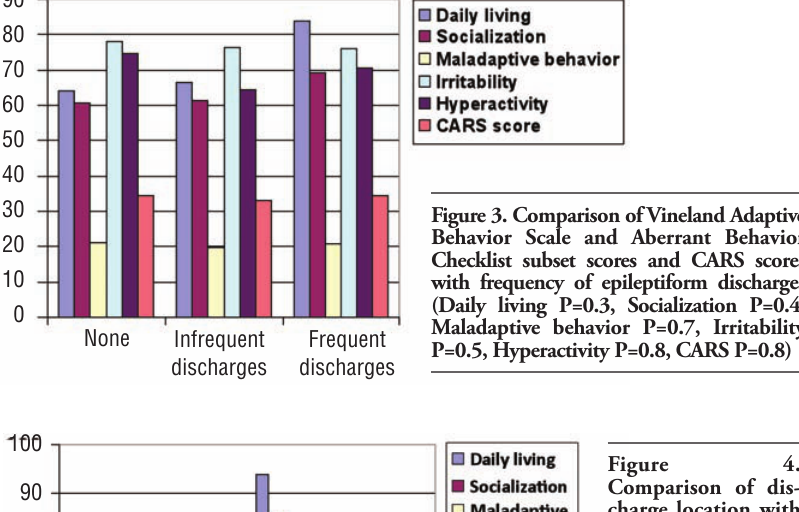
Figure 4. Comparison of dis- charge location with Vineland Adaptive Behavior Scale, Aberrant Behavior Checklist subset scores and CARS scores (Daily living P=0.3, Socialization P=0.4, Maladaptive behavior P=0.7, Irritability P=1.0, Hyperactivity P=0.9, CARS P=0.8).